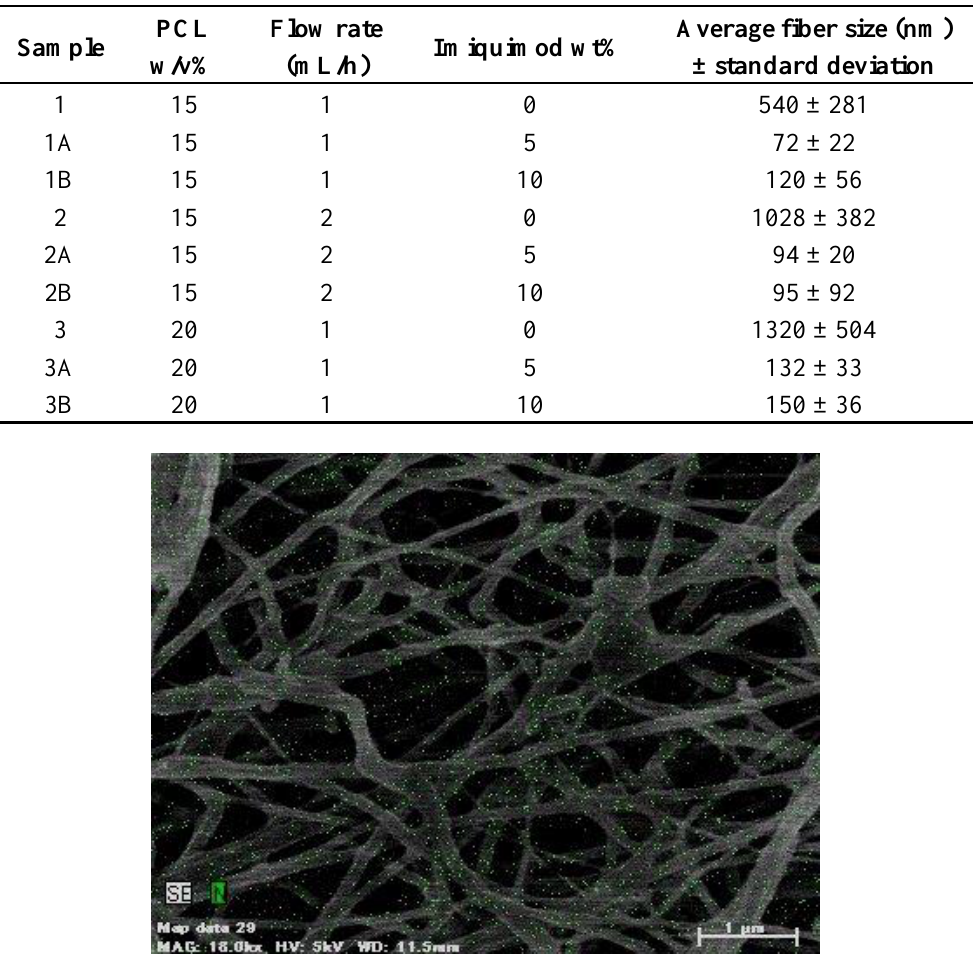
Figure 3. Energy Dispersive X-Ray Spectroscopy (EDX) mapping of sample 1A showing the nitrogen signal produced by imiquimod (green). Signal was detected for 1 min 30 s. Homogeneous distribution was seen across all